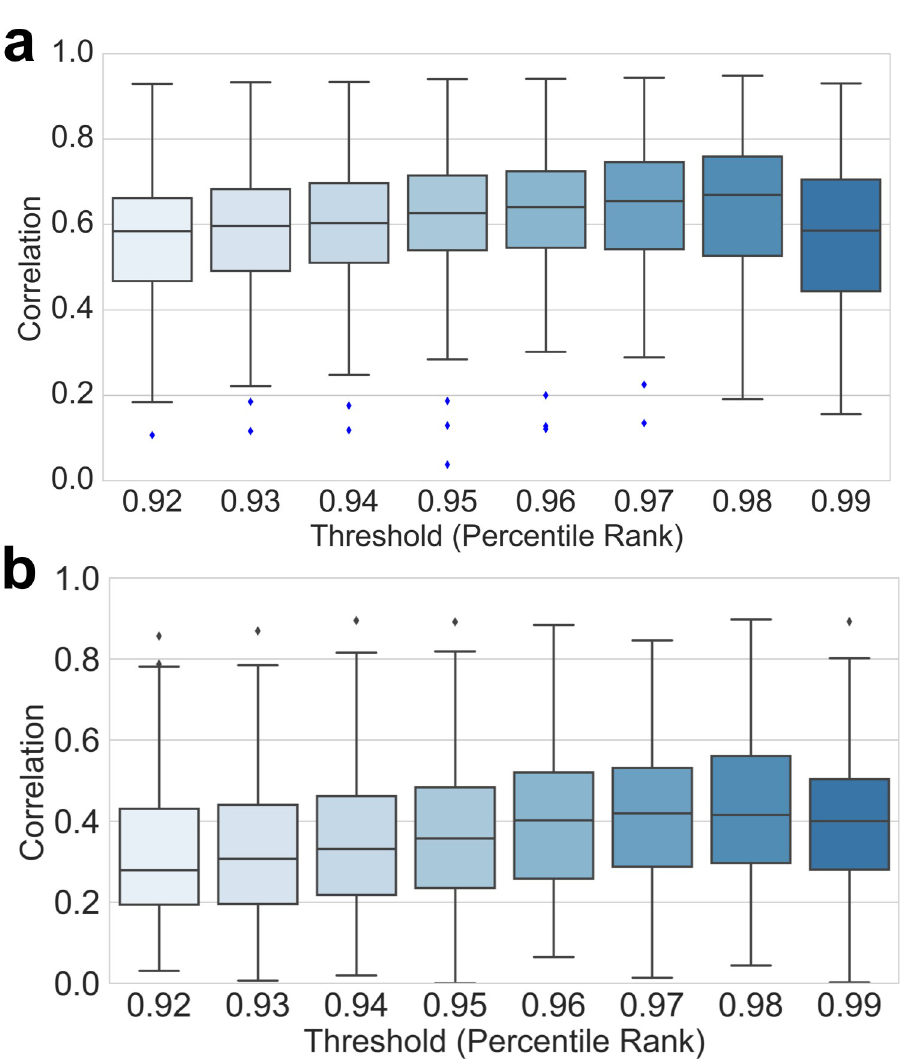
Fig 10. Comparison of theoretical B-factors. Boxplots comparing the correlations of predicted B-factors by our Seq- GNM for (a) RaptorX and (b) EVcouplings with that of the structural GNM for all 139 structures using a constant threshold for EC contacts. The GNM analysis is conducted 8 times using a constant threshold (between 0.92 and 0.99) each time. The best average correlations are produced when the constant threshold value of 0.98 is